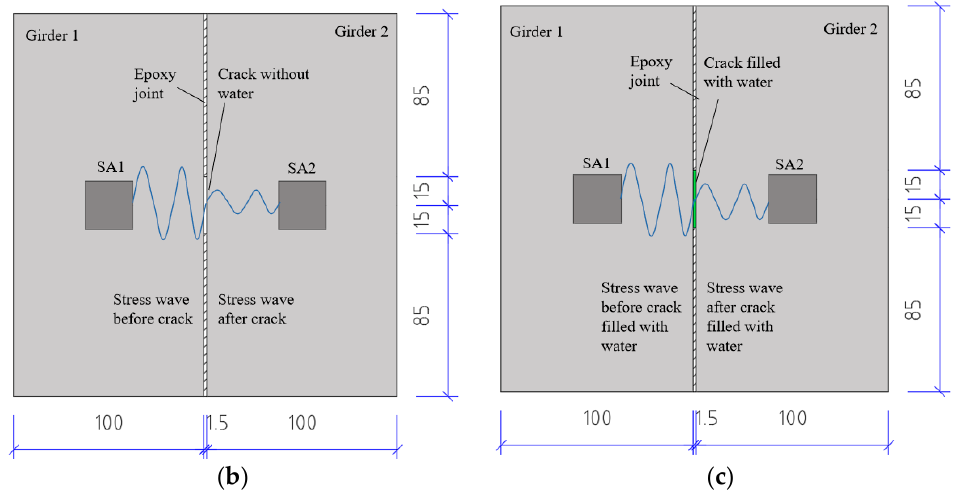
Figure 2. Schematic of stress wave propagating path (unit: mm). ( a ) No crack ( b ) With 3 cm crack; ( c ) With 3 cm crack filled with water.